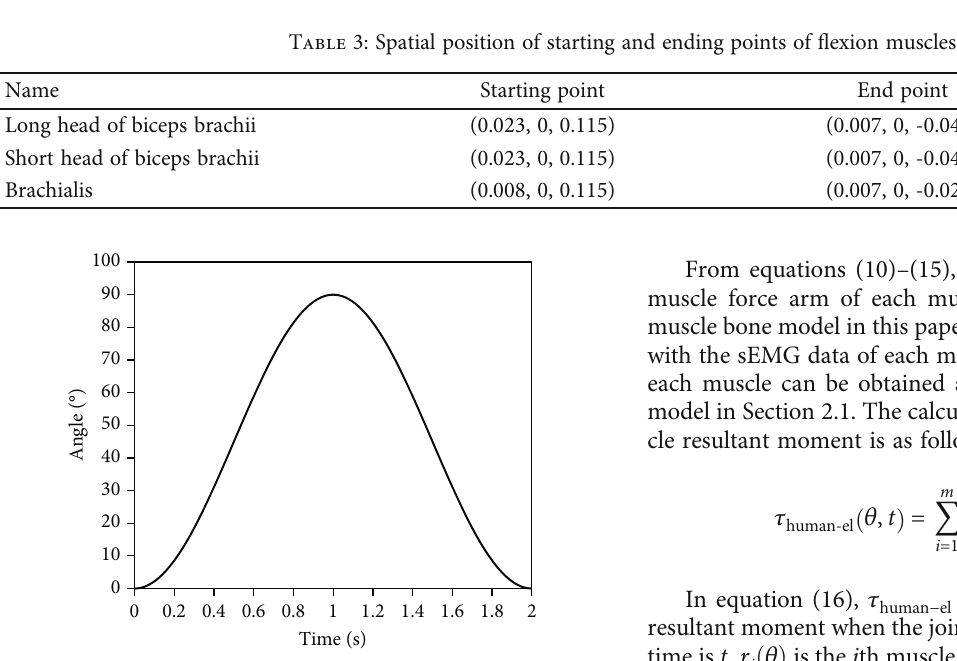
Figure 7: Planned elbow angle